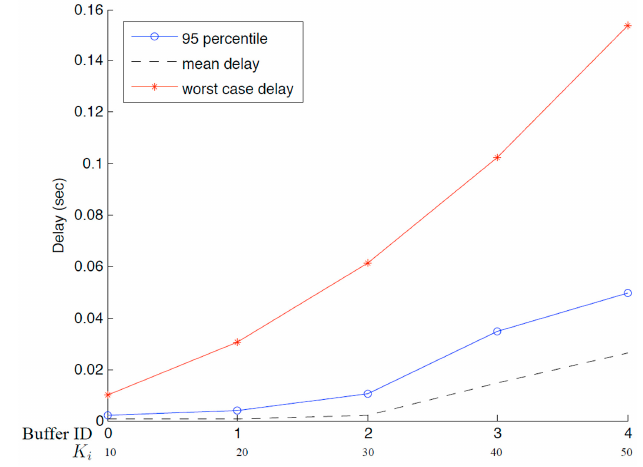
Figure 11. Delays for a system with M = 4 and m = 1.